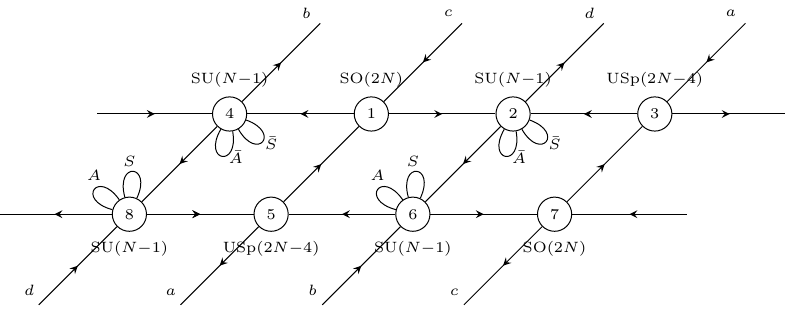
Figure 2 . Quiver theory on the torus constructed from the domain walls (4.2), (4.6), and (4.8). The diagonal lines are glued according to the letters a , b , c , d so that every SO or USp node connects to one USp, one SO, and two SU